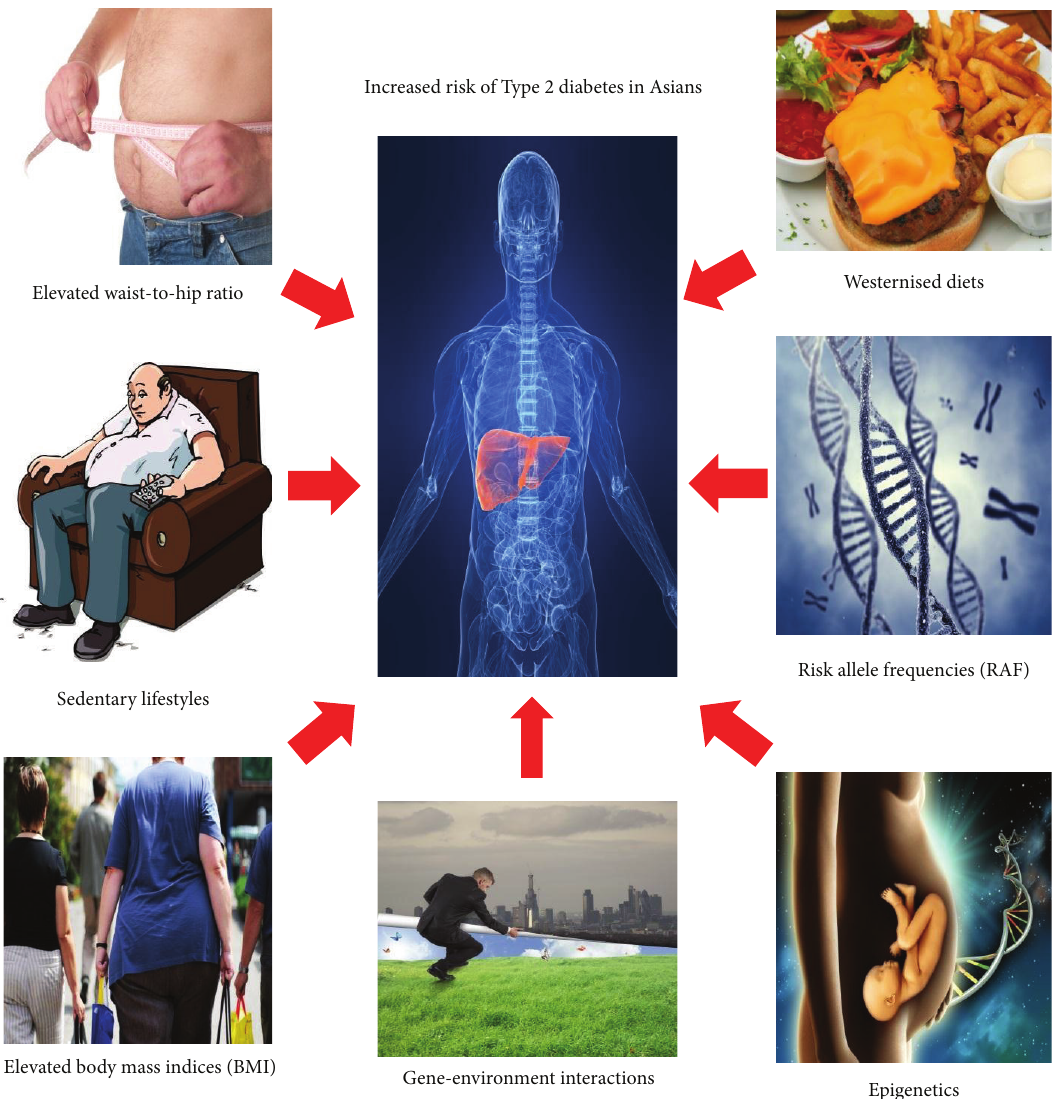
Figure 1: Genetic and nongenetic risk factors contributing to increased Type 2 diabetes risks within Asian populations and risk differences between Asian